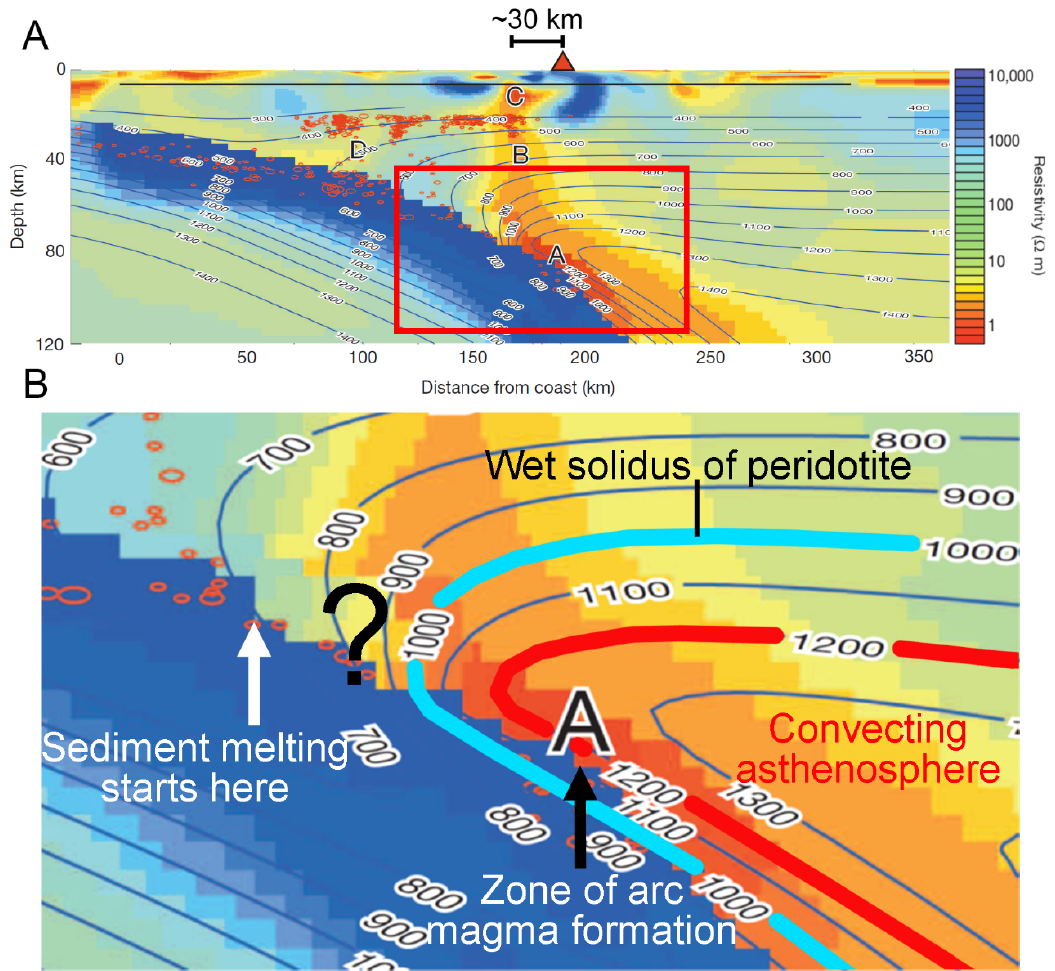
Figure 1. Cross section of a subduction zone and the region of fore-arc mantle metasomatism. ( A ) A–D show pathways of fluid migration at >30 km in front of the volcanic zone as evident from magnetotelluric observations. Reprinted by permission from Springer Nature, Nature, Pathway from subducting slab to surface for melt and fluids beneath Mount Rainier [30] ©2014. ( B ) At >675 °C [4] (white arrow), sediment-derived volatile-bearing partial melts of dacitic-rhyolitic composition (Figure 2) infiltrate the lithospheric fore-arc mantle at the location of the ‘?’ in front of the wet solidus isotherm of peridotite (blue line, [28]). Arc magmas form in the hot part of the mantle wedge ( A ) where temperatures are high enough to allow for the fluid- and sediment-fluxed (black arrow) melting of the asthenosphere.